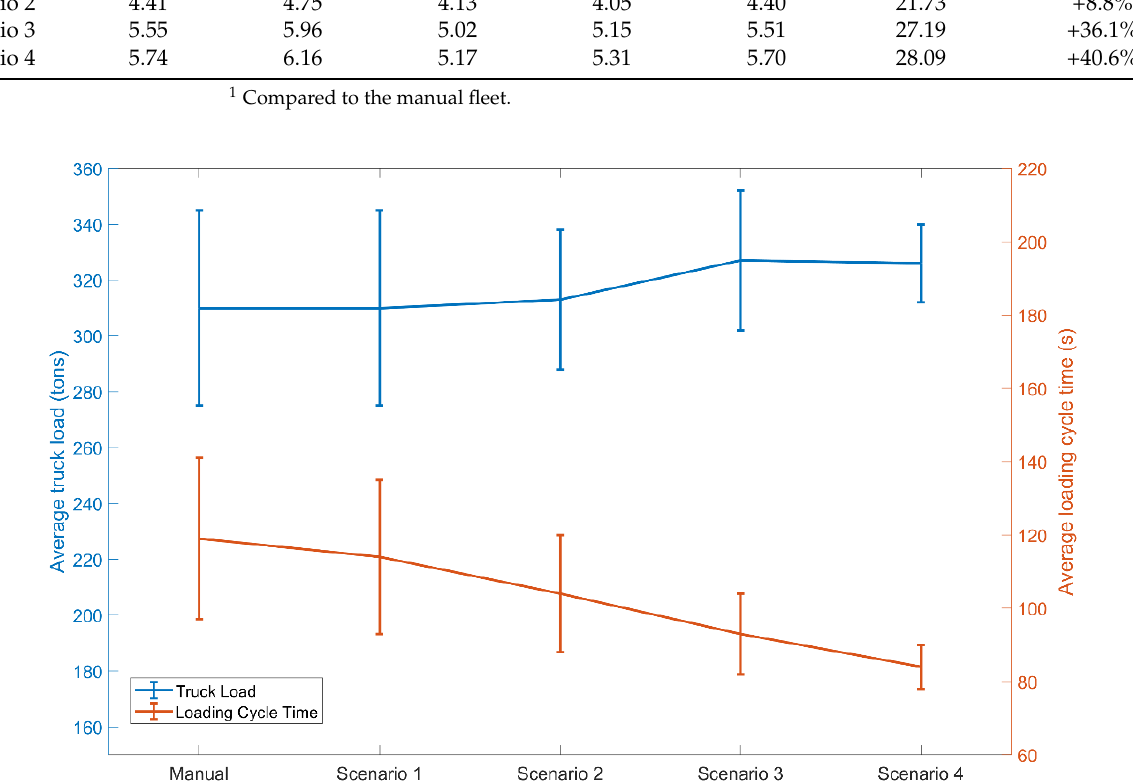
Table 8. Influence of shift change and break times on operational